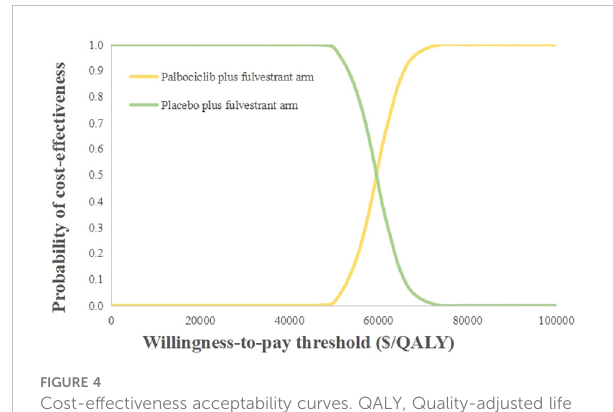
FIGURE 4 Cost-effectiveness acceptability curves. QALY, Quality-adjusted life